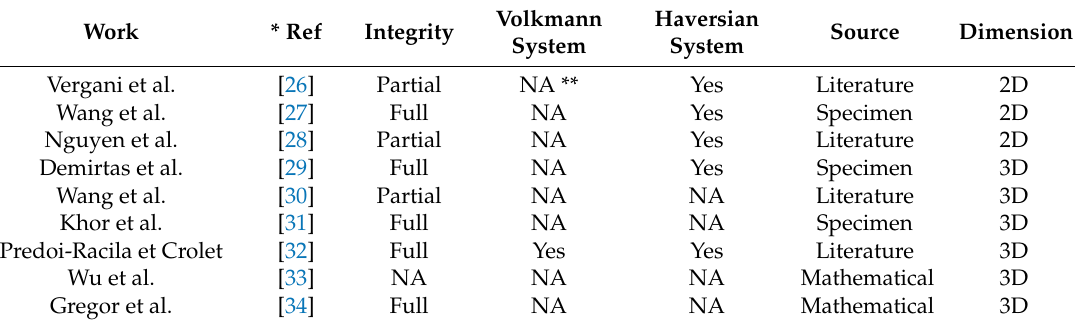
Table 1. Recent advancements in modeling and fabrication of bone